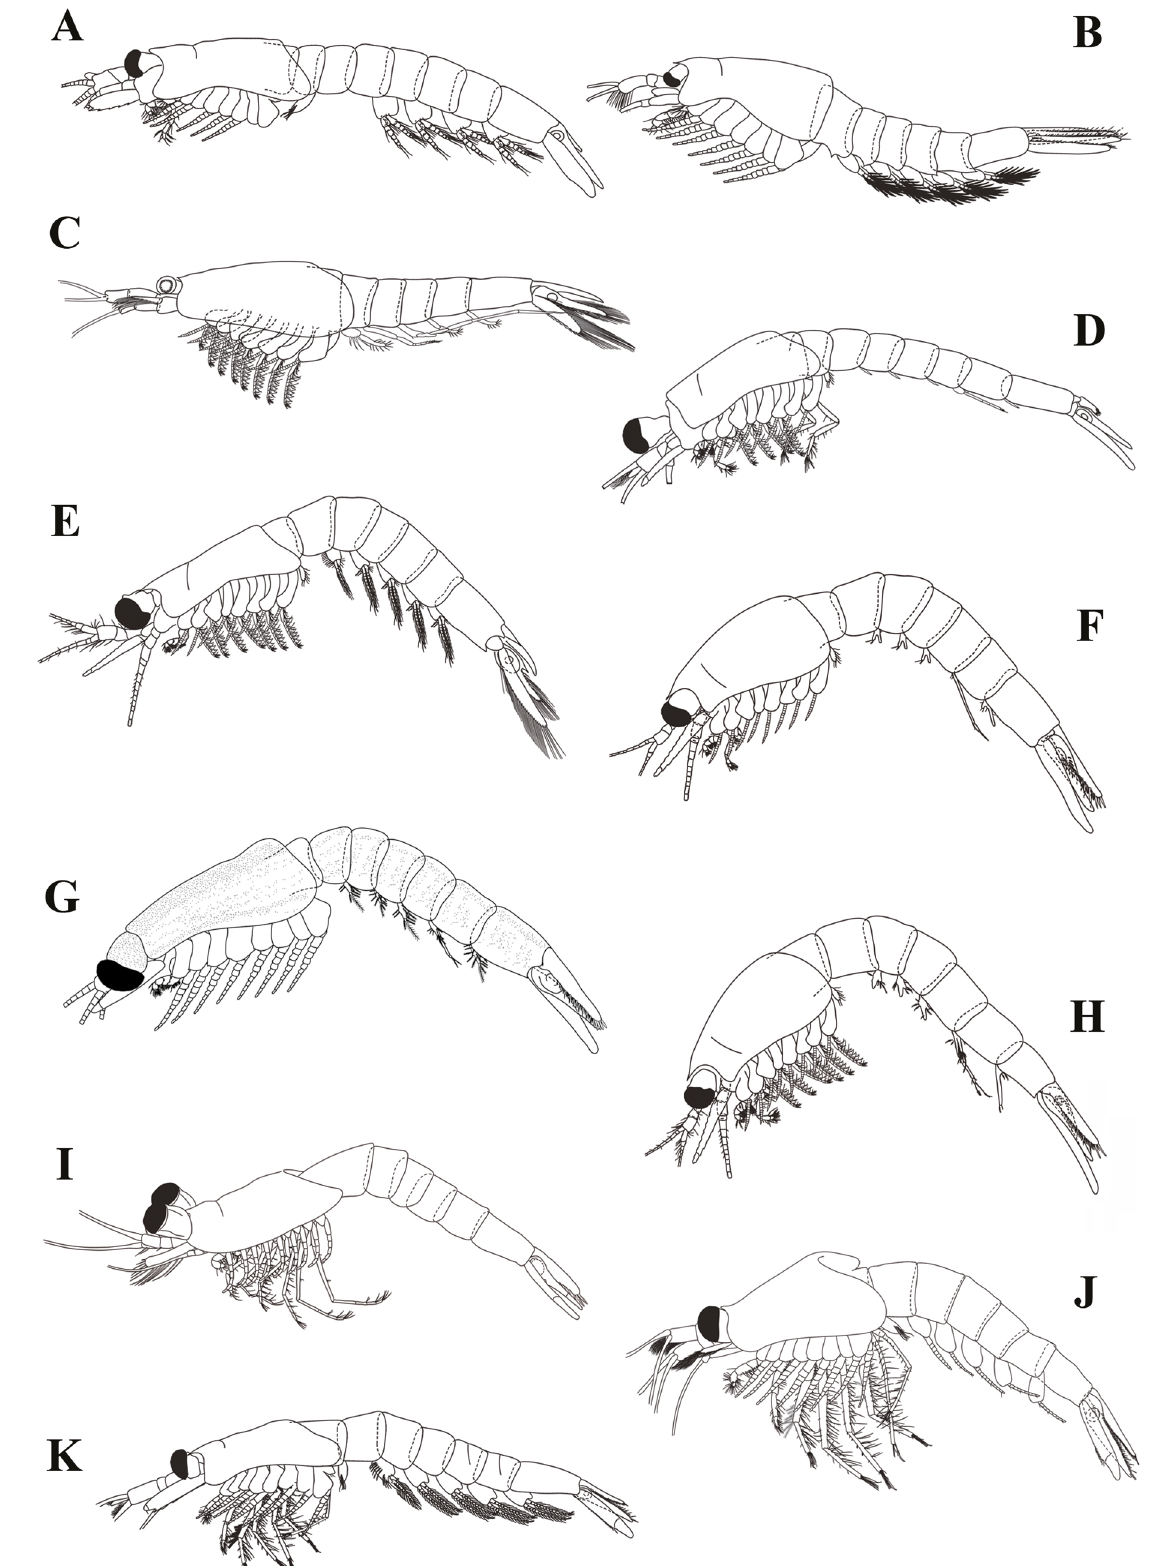
Figure 3. A. Erythrops minutus Hansen, 1910. B. Anchialina dentata Pillai, 1964. C. Haplostylus bengalensis (Hansen, 1910); D. Anisomysis (Anisomysis) aikawai Ii, 1964. E. Prionomysis aspera Ii, 1937. F. Acanthomysis longispina Fukuoka and Murano, 2002. G. Acanthomysis platycauda (Pillai, 1961). H. Acanthomysis quadrispinosa Nouvel, 1965. I. Rhopalophthalmus longipes Ii, 1964. J. Siriella vulgaris Hansen, 1910. K. Siriella media Hansen,